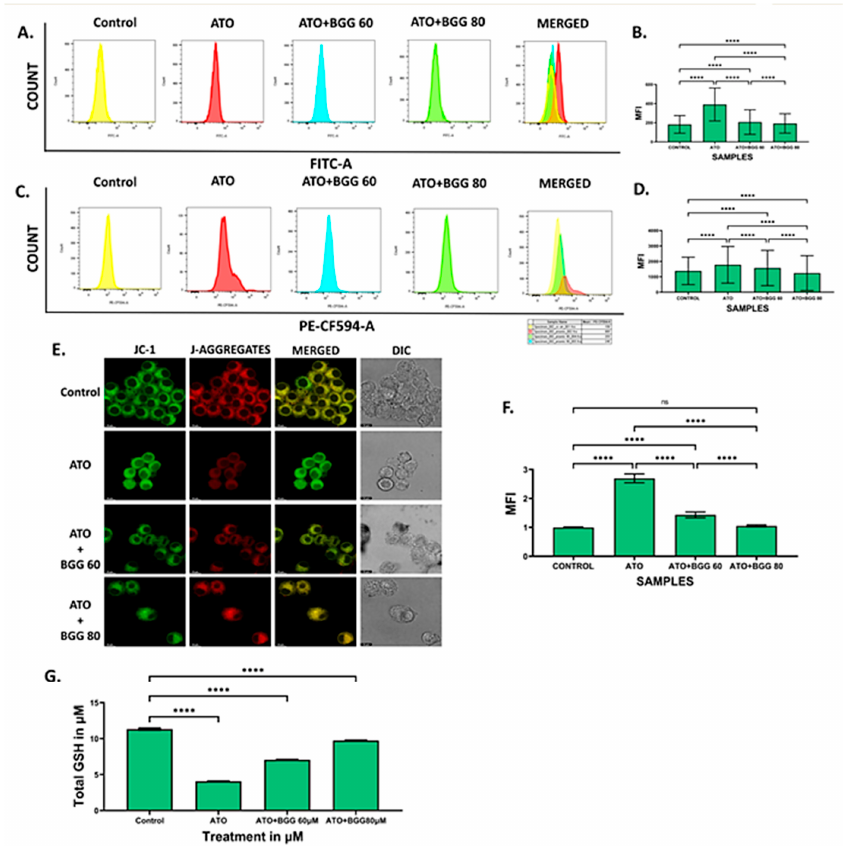
Figure 2. BGG attenuates the ATO-induced ROS, mitochondria superoxide, and mitochondria mem- brane potential depolarization. RAW 264.7 cells were pre-treated with 60 µ M and 80 µ M of BGG for 1 h, followed by ATO (5 µ M) treatment for 23 h of stimulation; ( A ) ROS measurements by FACS after staining with DCFDA, ( B ) graph represents the mean fluorescence intensity (MFI) ± SD of the DCFDA experiments, ( C ) FACS assay for the measurement of superoxide production after staining with MitoSox, ( D ) graph represents the mean fluorescence intensity (MFI) ± SD of MitoSox exper- iments, ( E ) JC-1 staining, confirming that BGG attenuates the ATO degraded membrane potential measured by confocal microscopy in RAW 264.7 cells, ( F ) graph represents the mean fluorescence intensity of showing a ratio of JC-1 monomer vs. JC-1 aggregates, and ( G ) GSH assay. (Mean ± SEM) ( n = 3), p -value (**** p < 0.0001, ns =